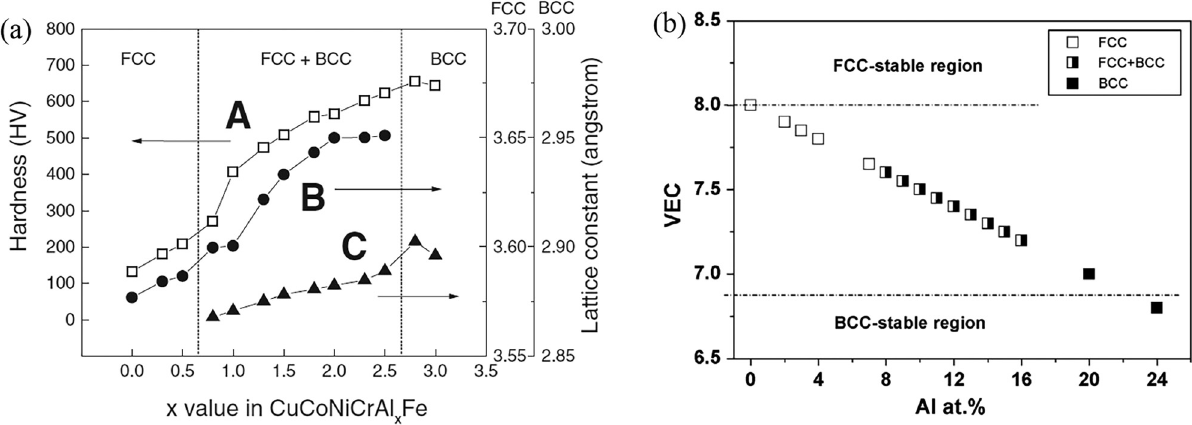
Figure 4: E ff ect of Al content on the structure of BCC and FCC in HEAs, ( a ) CuCoNiCrAl x Fe HEA [ 22 ] , ( b ) ( FeCoNiCrMn ) 100 ‒ x Al x HEA [ 86 ]